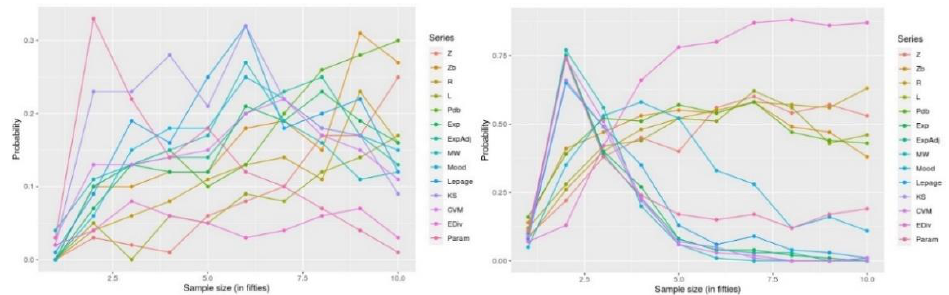
Fig. 6. Checking asymptotic consistency with K = 2, left panel - failure truncation, right panel time truncation.